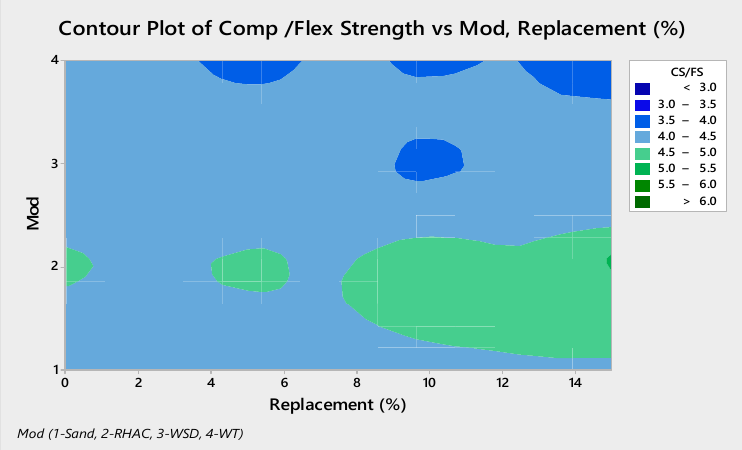
Figure 7. Contour plot of compressive/flexural strength (MPa) vs. mod, replacement (%). Further, tensile to flexural balance is also discussed, and it is found out that is avail- able up to 6% replacement of filler material, and after this, it reduces as shown in Figure 8. Afterward, the value of these strength properties fluctuates due to which imbalance situation occurs among these modifiers. Overall, the sand and RHAC counted to be bal- anced modifiers as parallel to remain modifiers.